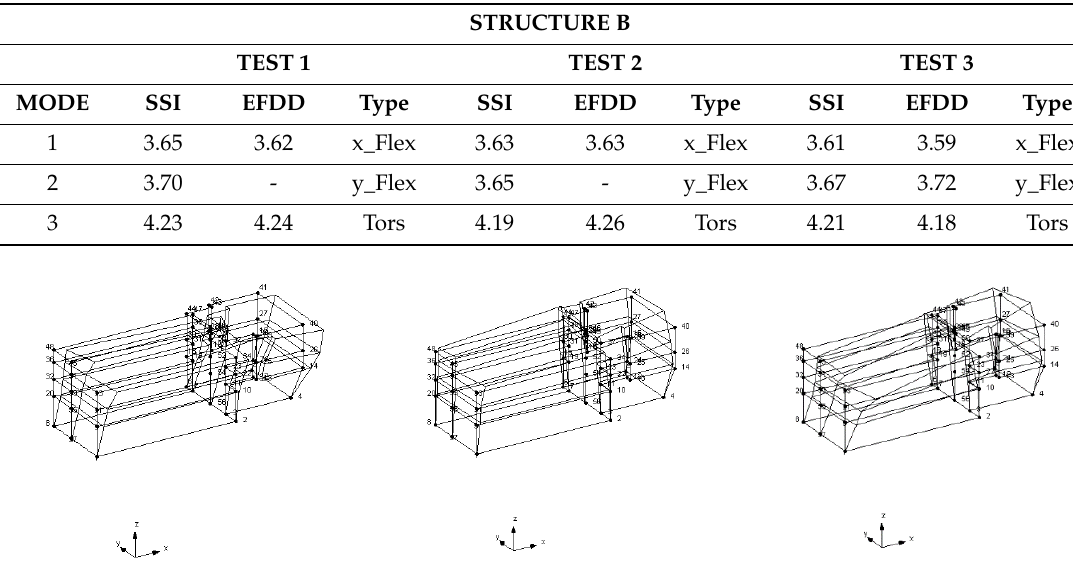
Table 2. Experimental identified frequencies [Hz] with SSI and EFDD techniques and mode shape type.